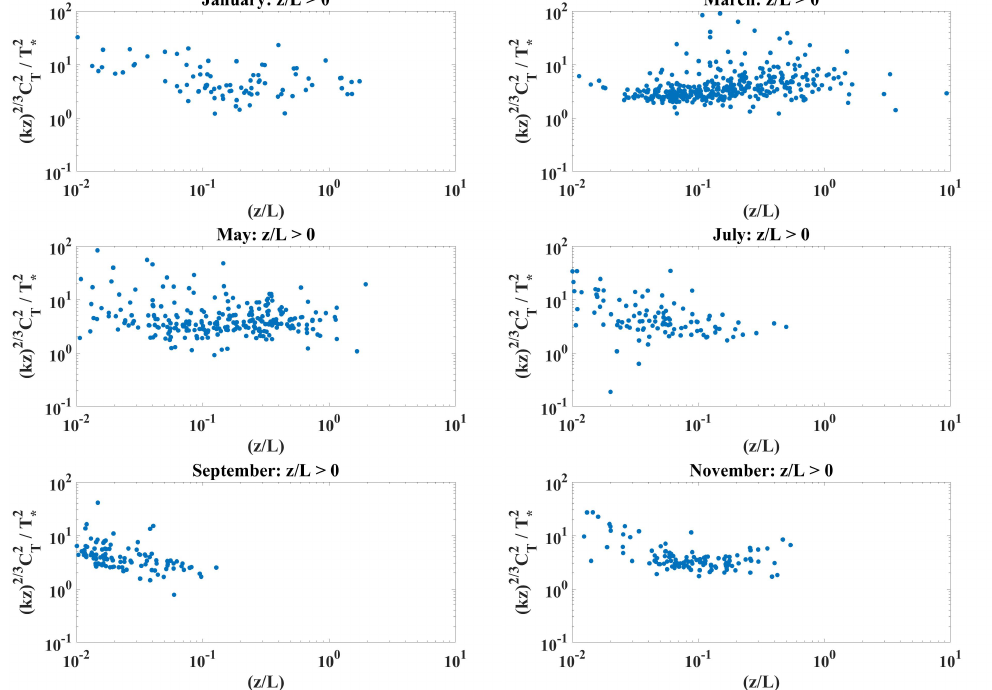
Figure 11. Normalized temperature structure by month for z/L >